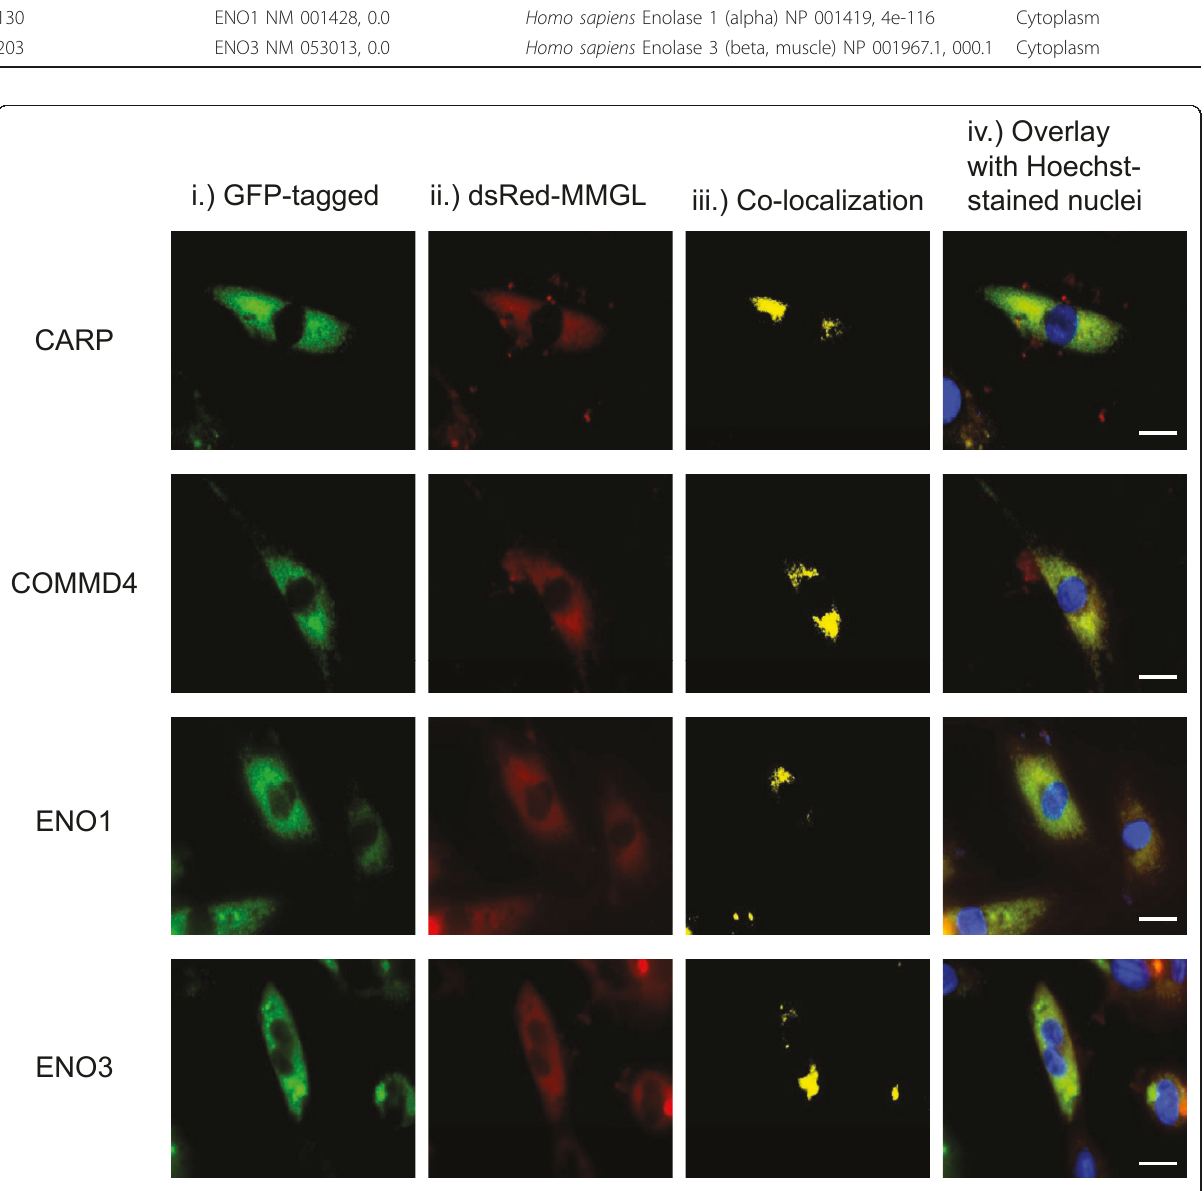
Figure 4 3D co-localization of MMGL and its respective preys identified in the Y2H library screen . Representative images of live cell fluorescence microscopy showing co-localization of MMGL and the putative interactors identified in the Y2H library screen in differentiated H9C2 cardiac myocytes. (i) Individual GFP-tagged putative library screen interactors are seen as green fluorescence, as indicated by labels to the left of the row. (ii) dsRed-tagged MMGL expression in the same cell(s) are shown are red fluorescence. (iii) Co-localization of interactors and MMGL within these cell(s), generated from 3D vertical Z-stack images, are shown as yellow fluorescence. (iv) Overlay of images A-C with Hoechst H-33342 labelling of the nuclei (blue) for orientation purposes. The presence of yellow staining in each of the images in (iii) indicates that each of the respective preys colocalize with MMGL in differentiated H9C2 cardiomyocytes. Scale bar: 0.02